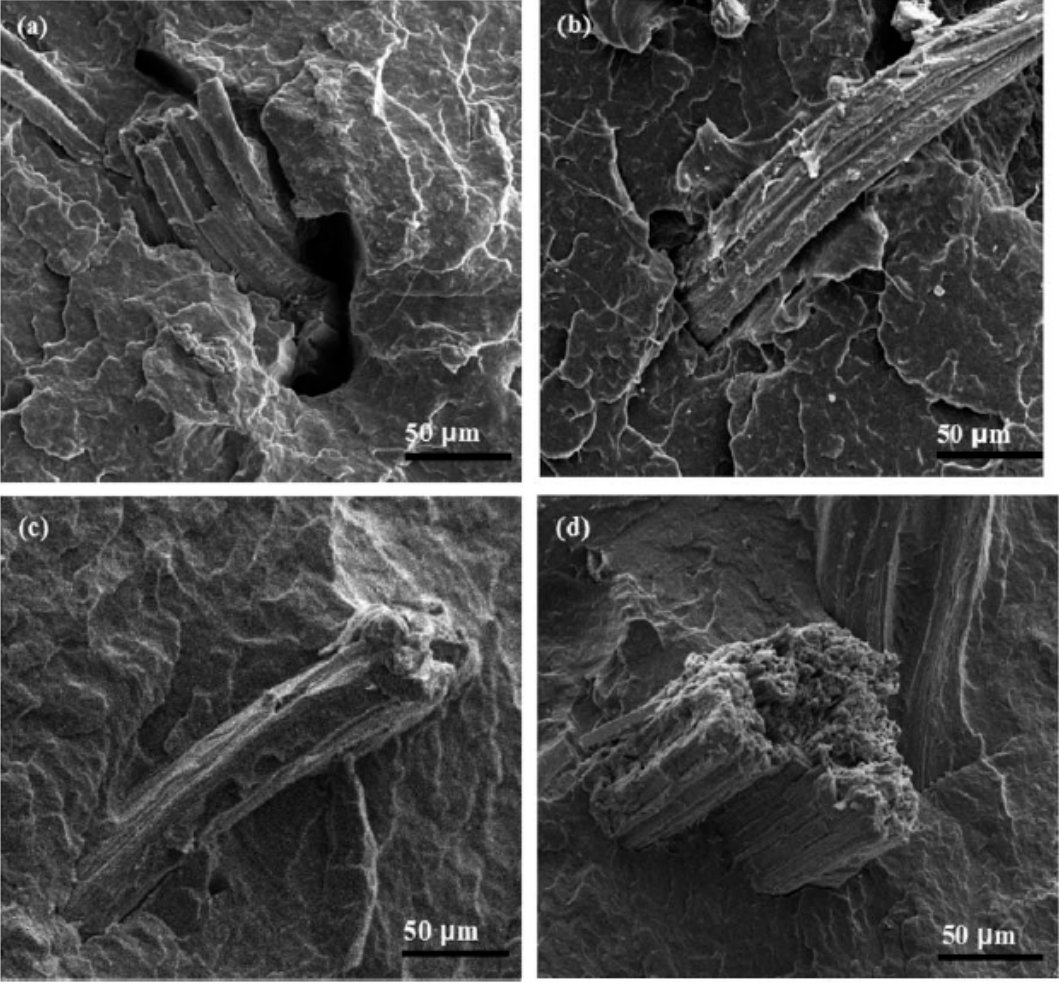
Figure 8. Fracture surface micrographs of PP composites: ( a ) SF / PP composite; ( b ) GO-SF / PP composite; ( c ) SF / MAPP-PP composite; ( d ) GO-SF / MAPP-PP composite. Reproduced with permission from [53].